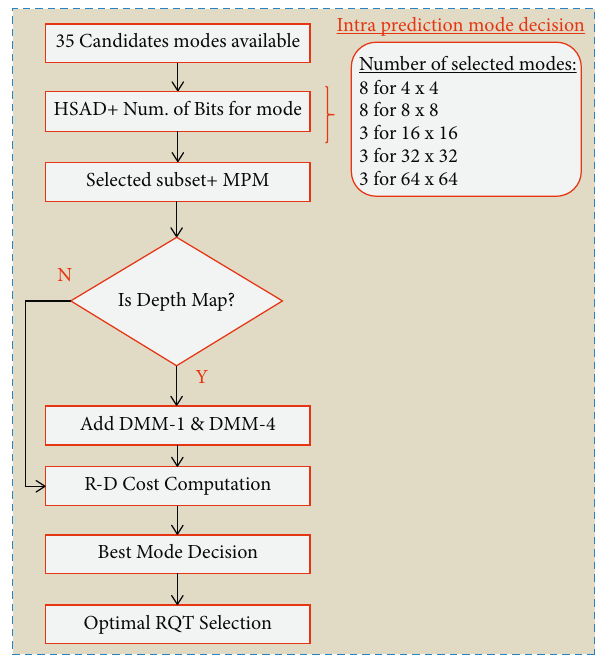
Figure 3: The depth map intraprediction process in 3D-HEVC. Table 2: Depth map intraprediction mode